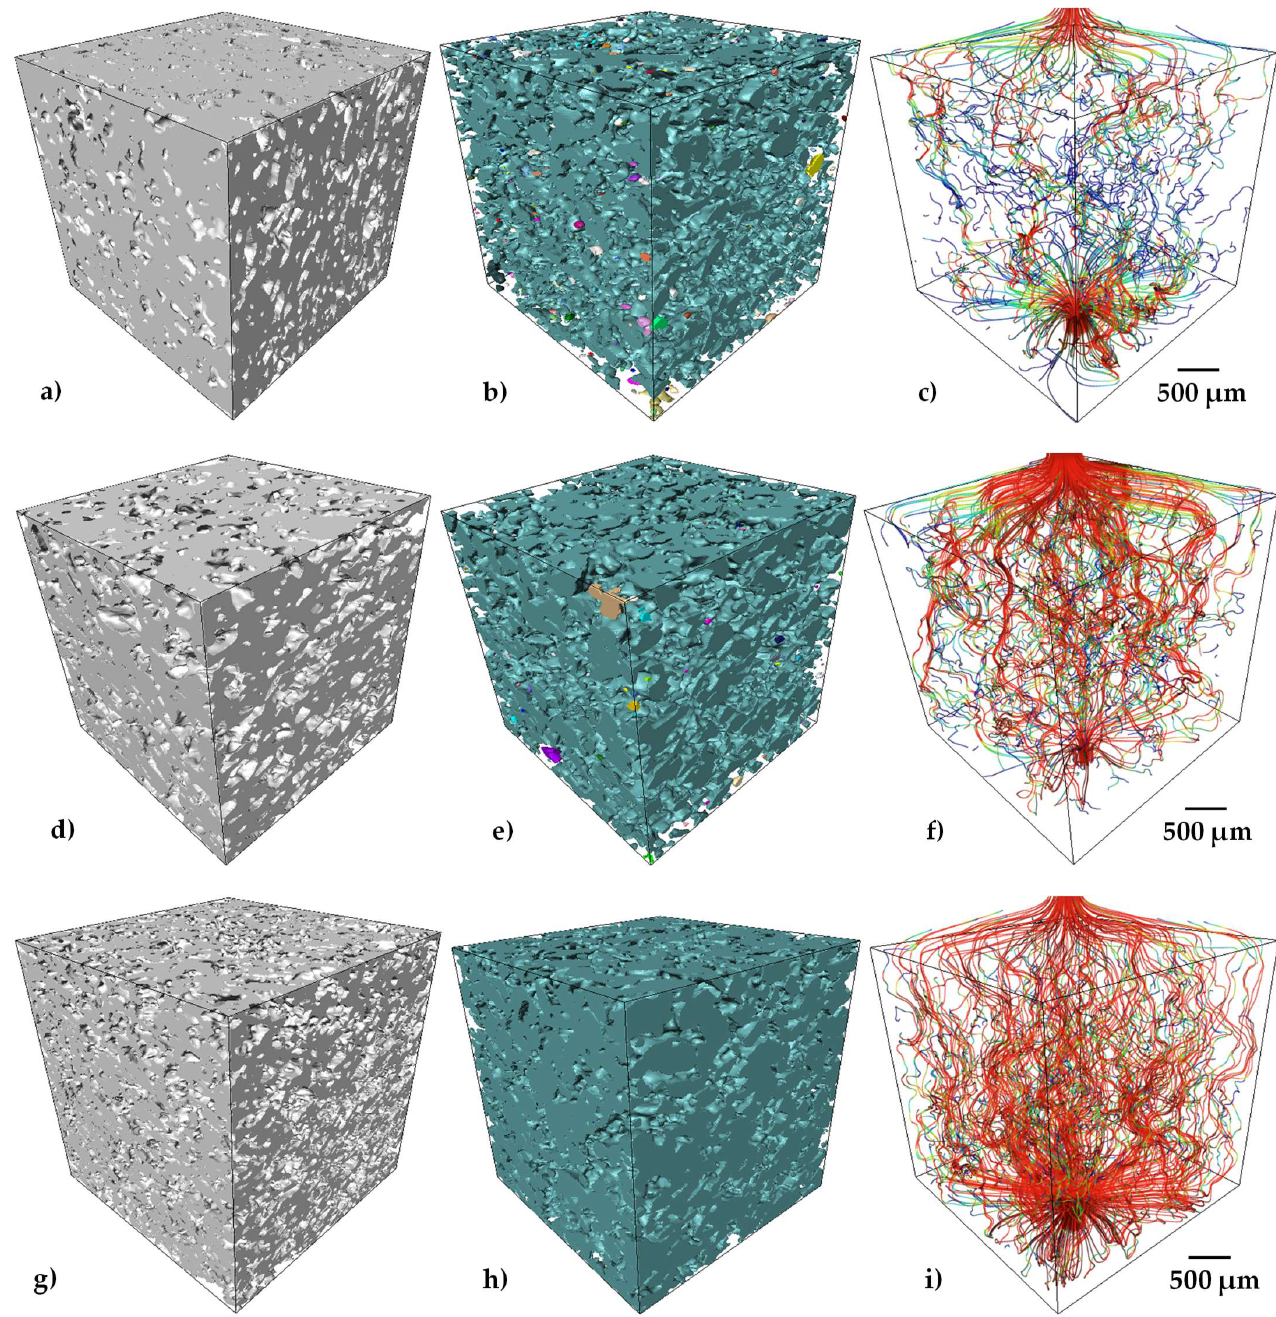
Figure 6. 3D volume renderings of solid Ti64/20Ag, porosity and the streamlines for the simulated flow of fluid through the void space in samples. The colors of the streamlines illustrate the fluid velocity for Ti64/20Ag samples with 30 vol.% ( a – c ), 40 vol.% ( d – f ) and 50 vol.% ( g – i ) of pore formers.